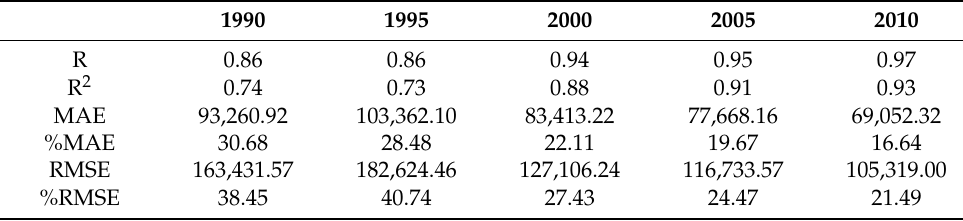
Table 2. Accuracy assessment of RSPop at county scale from 1990 to